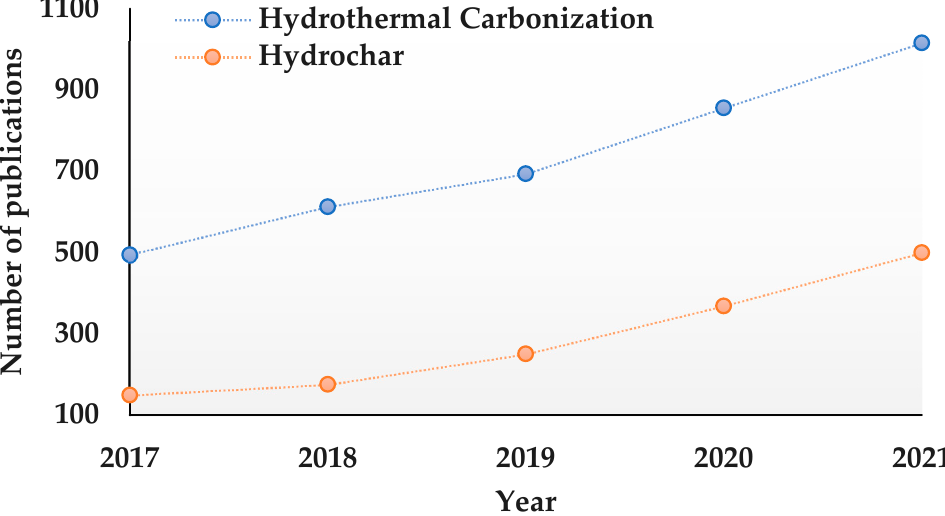
Figure 1. Number of publications including HTC and hydrochar on the title in last five years [29].